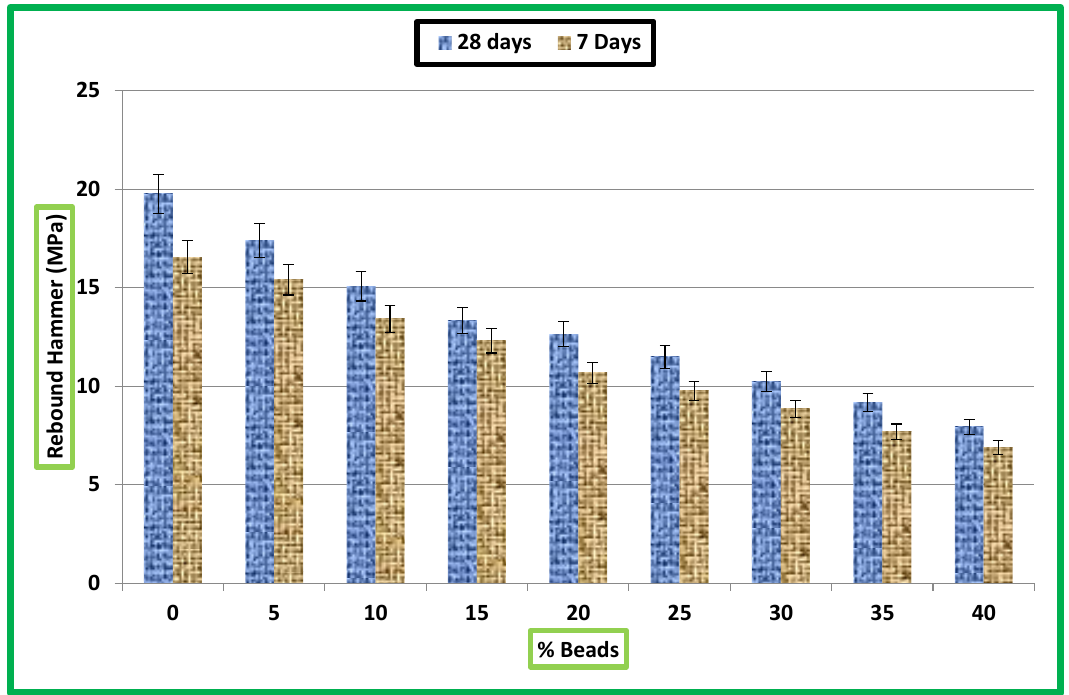
Figure 16. Rebound hammer-based compressive strength (MPa) at 7 and 28 days.